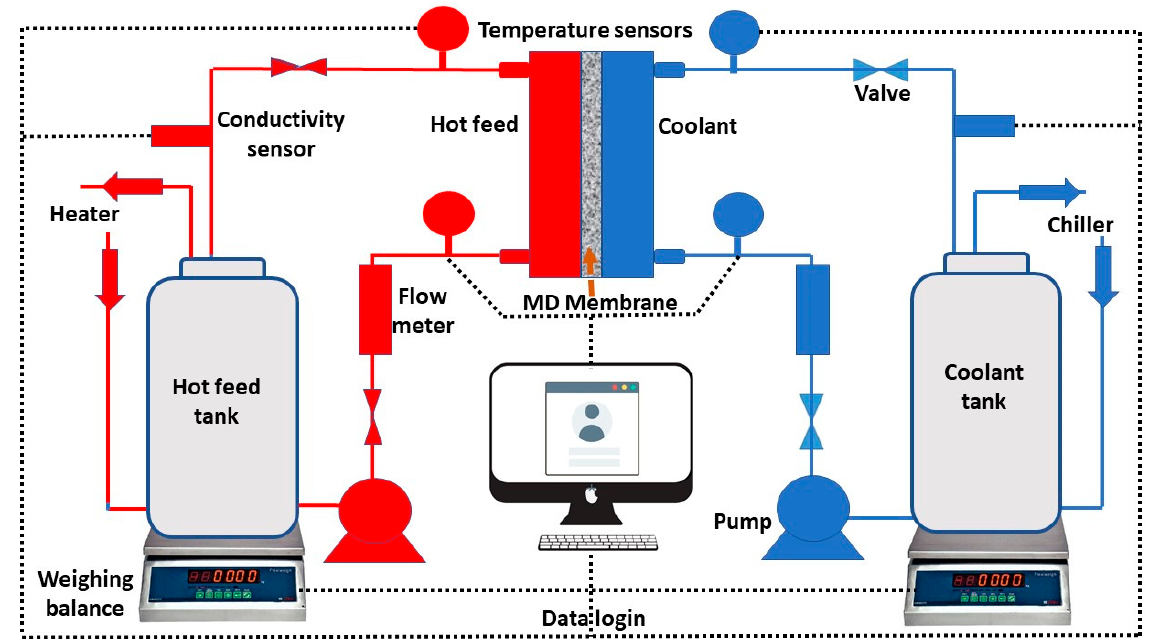
Figure 2. Schematic representation of experimental DCMD setup.